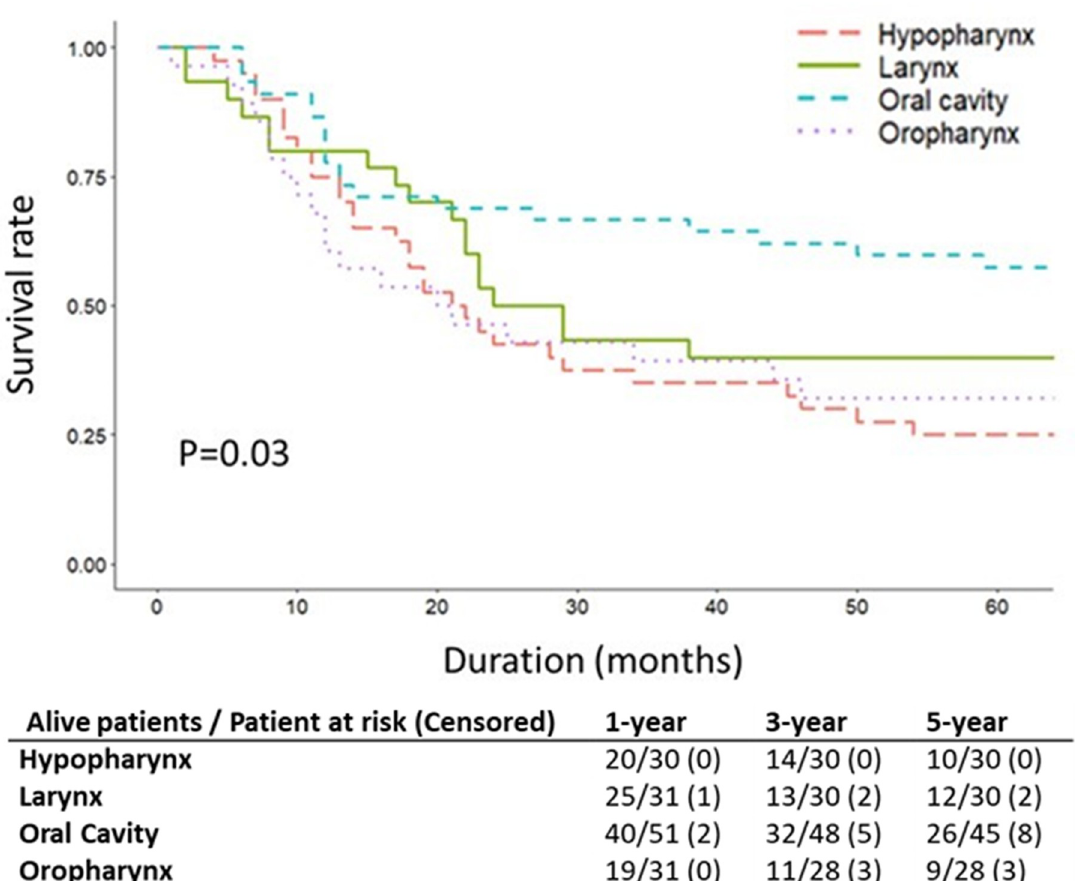
Fig 2. Kaplan-Meier survival curves for first primary malignancy subsites in cases who developed secondary primary